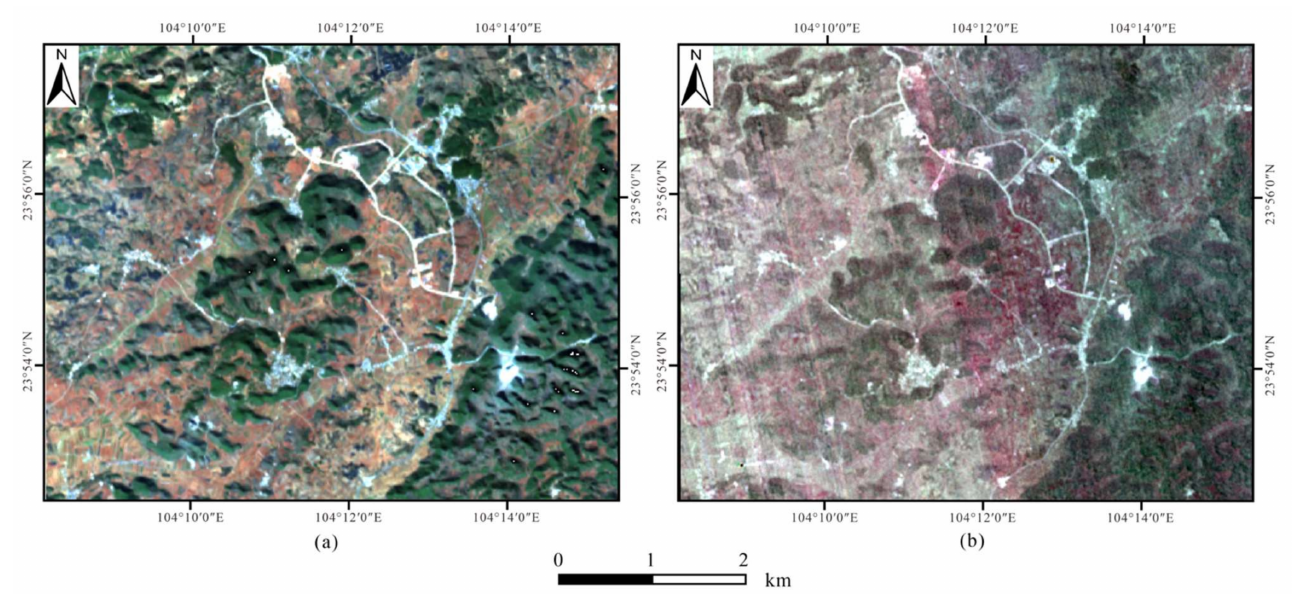
Figure 11. MNF analysis curve.